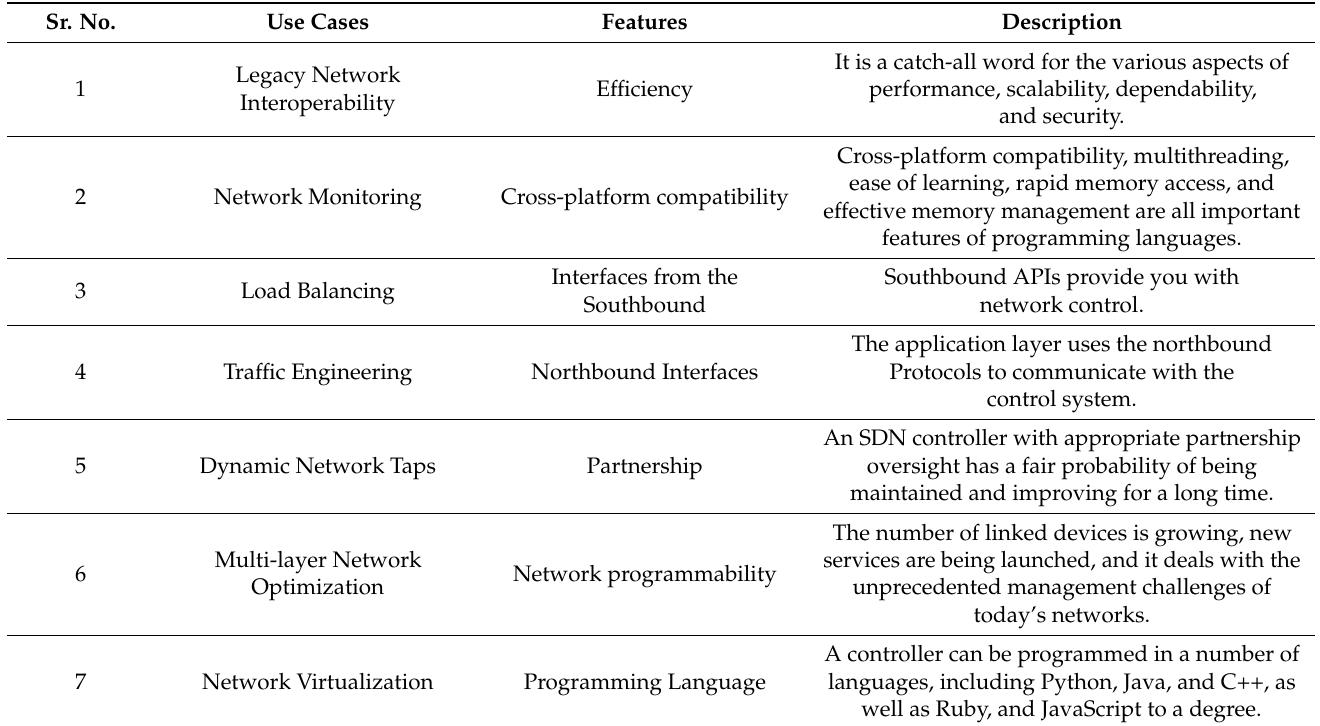
Table 6. Use cases and features of